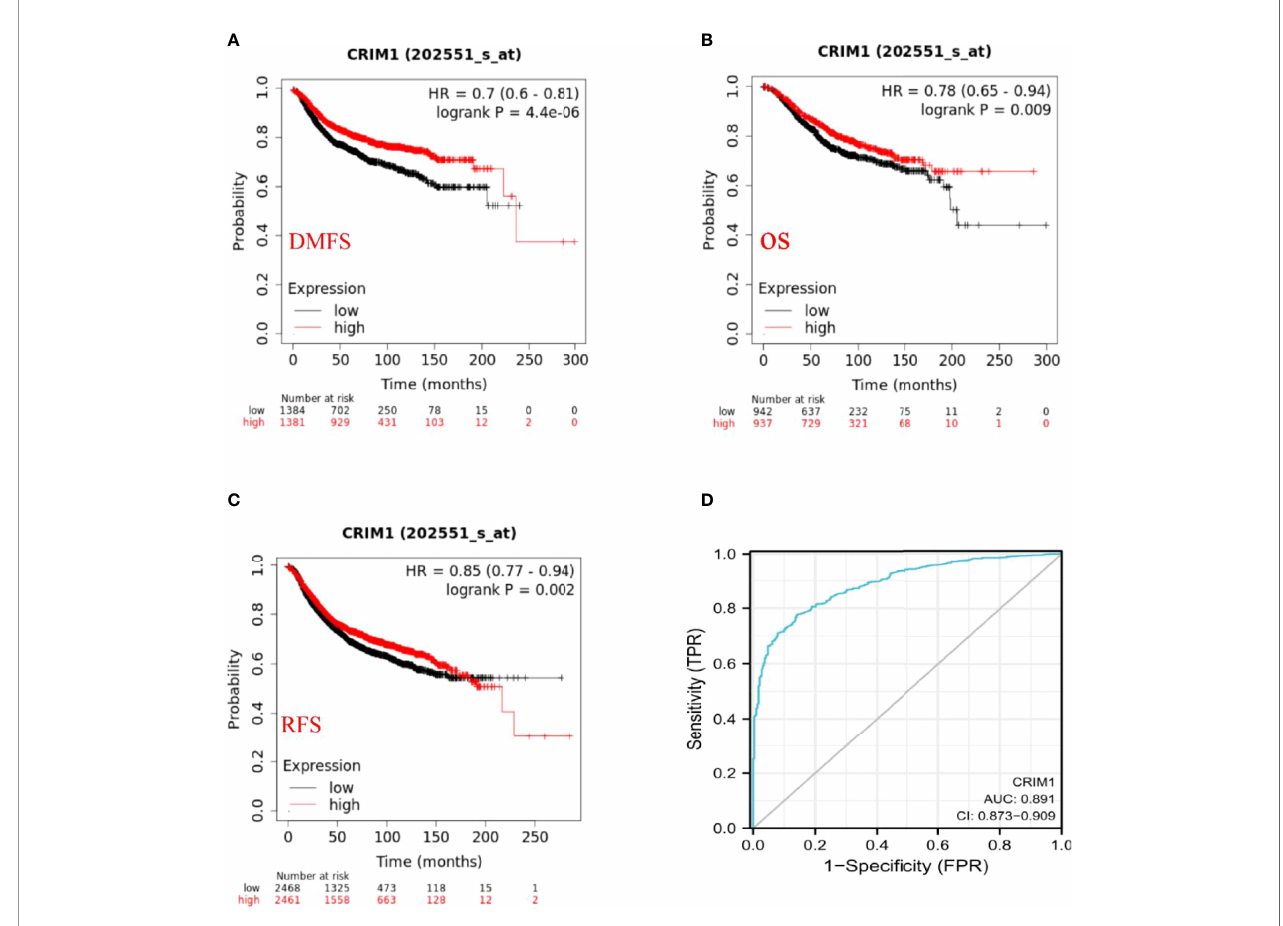
FIGURE 5 | Prognostic signi fi cance of CRIM1 expression in breast cancer (A – D) . (A – C) Kaplan-Meier analysis revealed that high CRIM1 levels were correlated with better DMFS (distant metastasis-free survival), OS (overall survival), and RFS (relapse-free survival). (D) Receiver operating characteristic (ROC) curve analysis of the correlation between CRIM1 and survival in breast cancer patients showed that CRIM1 had good performance in predicting breast cancer survival.